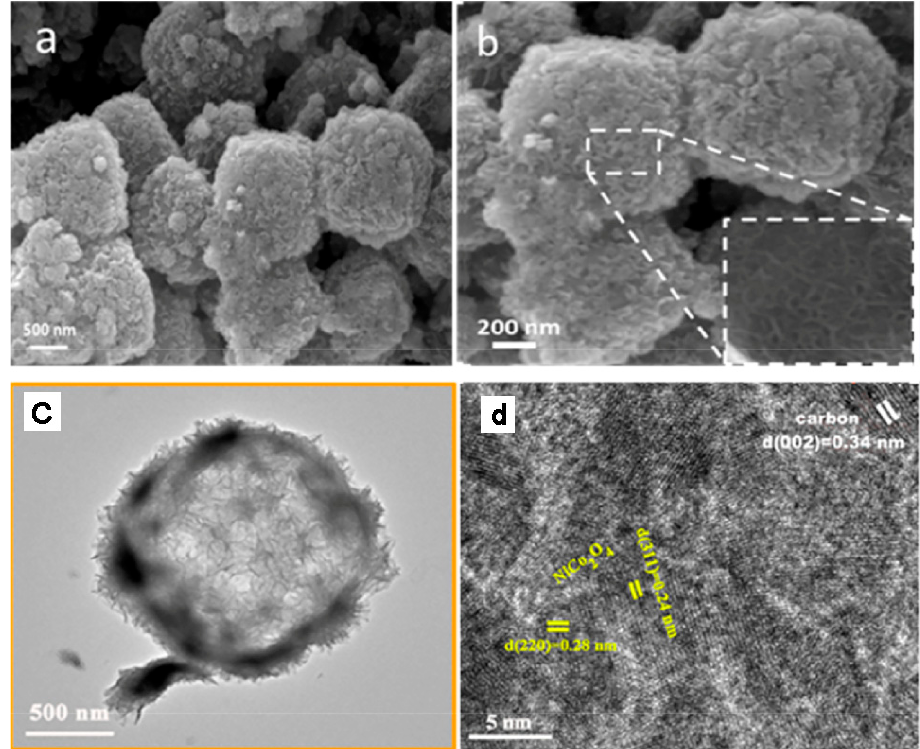
Figure 6. SEM ( a , b ), ( c ) TEM, and ( d ) HRTEM images of hollow N-doped carbon/NiCo 2 O 4 . Repro- duced with permission from [86]. Copyright 2020, Elsevier.